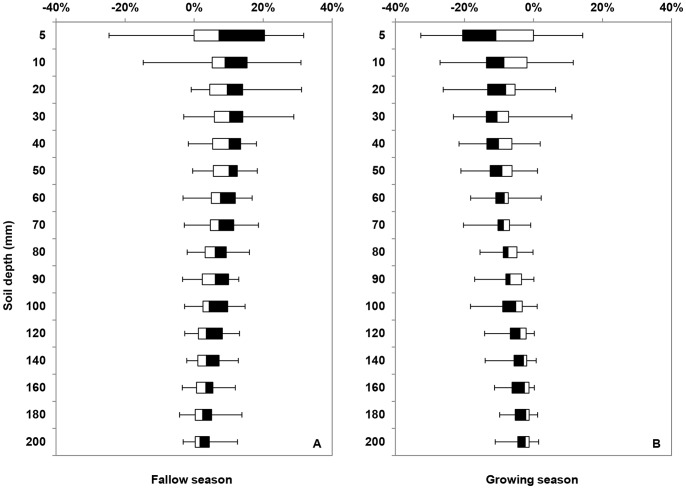
Changes in soil water content in the upper 2 meter of the soil during the period of 1980–2010. A: water stored in the upper 2 meter during the fallow season, presented in positive percentage (in volume, v/v). B: water depletion in the upper 2 m during the growing season, presented in negative percentage (in volume, v/v).The soil water changes for fallow season were calculated as the soil water content of October deducted by that of June. Similarly, the soil water changes for growing season were calculated as the soil water content of June deducted by that of October in the previous year.